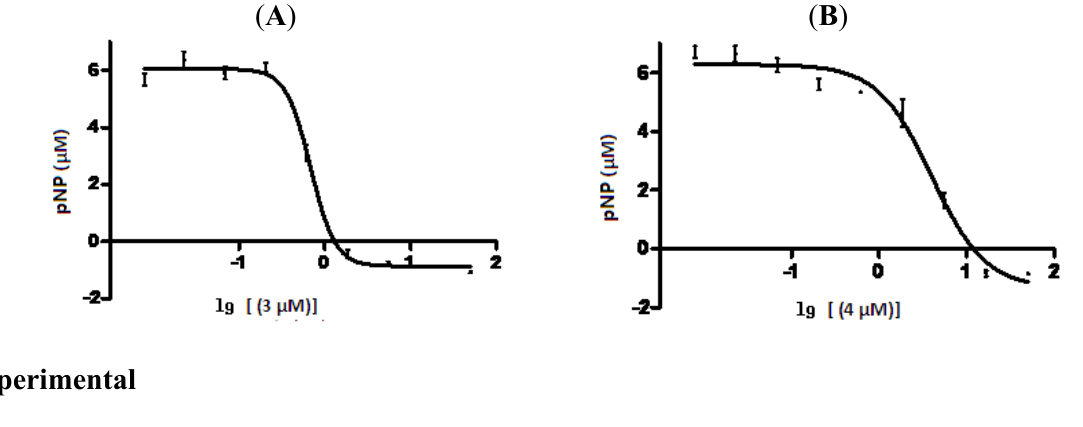
Figure 5. Inhibition of Compounds 3 ( A ) and 4 ( B ) on PTP1B activity in vitro